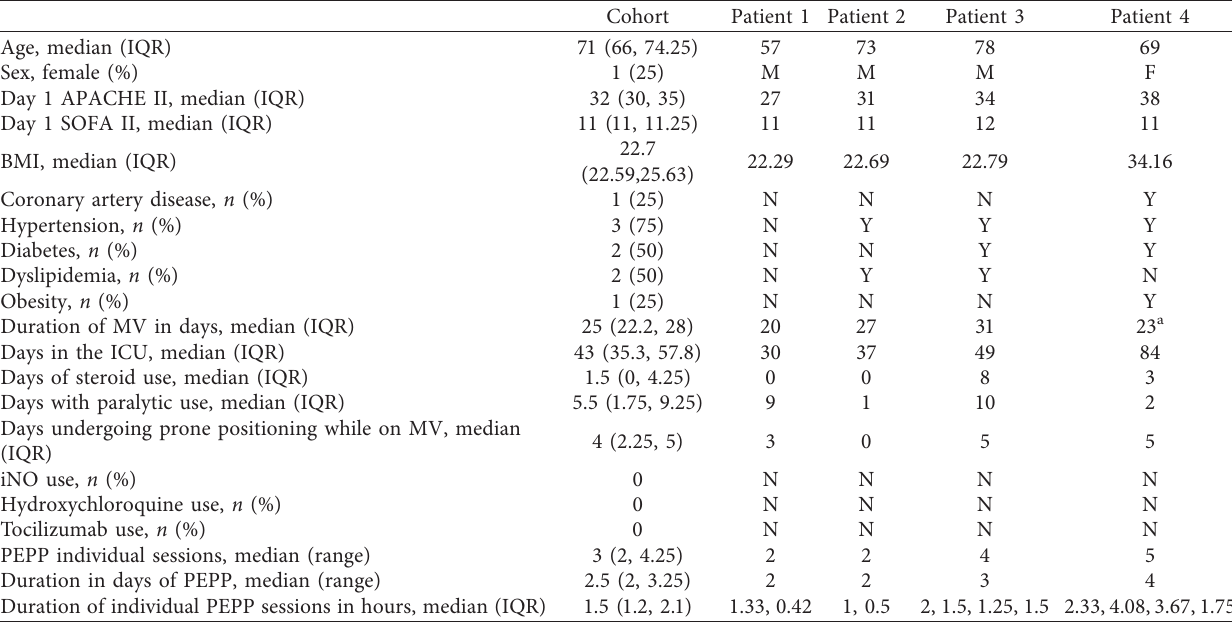
Figure 1: Search flow Table 1: Patient characteristics and descriptive statistics.